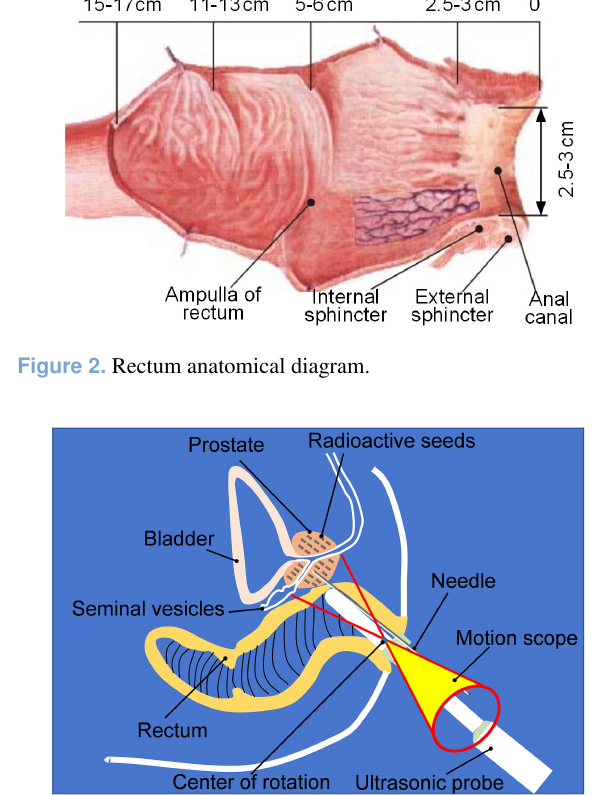
Figure 3. Motion scope of the ultrasonic